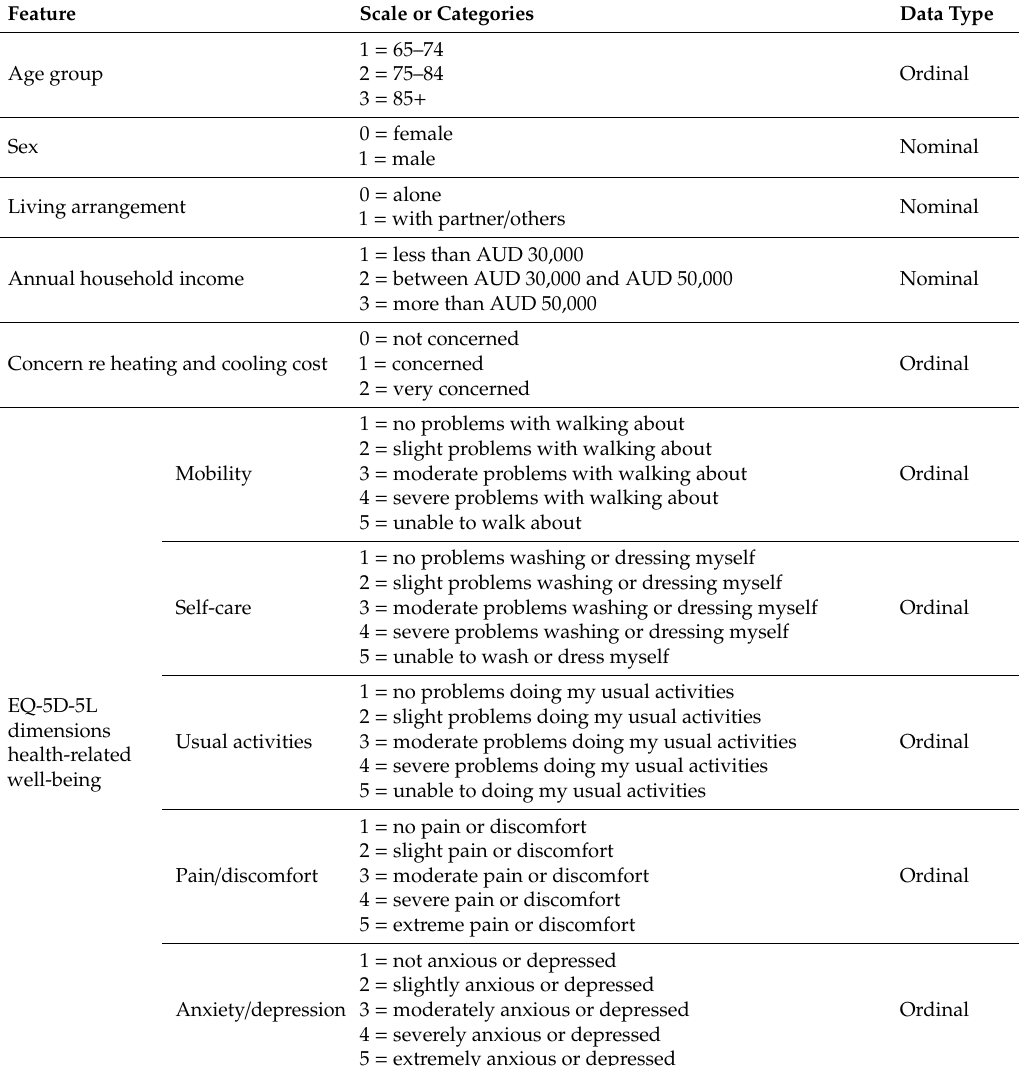
Table 1. Features used for development of the thermal